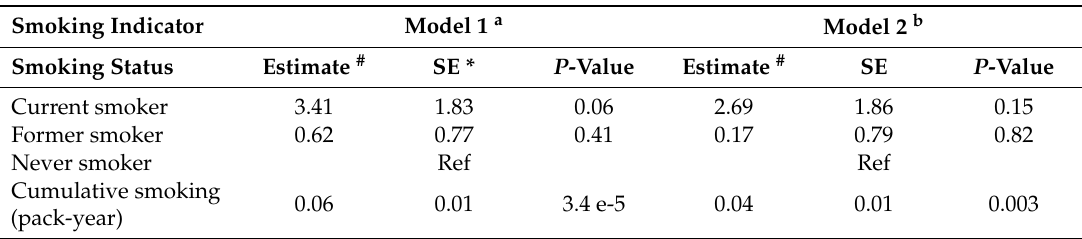
Table 2. Association of DNA methylation phenotypic age (DNAmPhenoAge) acceleration with self- reported smoking and epigenetic smoking indicators in the Veterans Affairs Normative Aging Study Cohort in Boston, MA, 1999–2013.